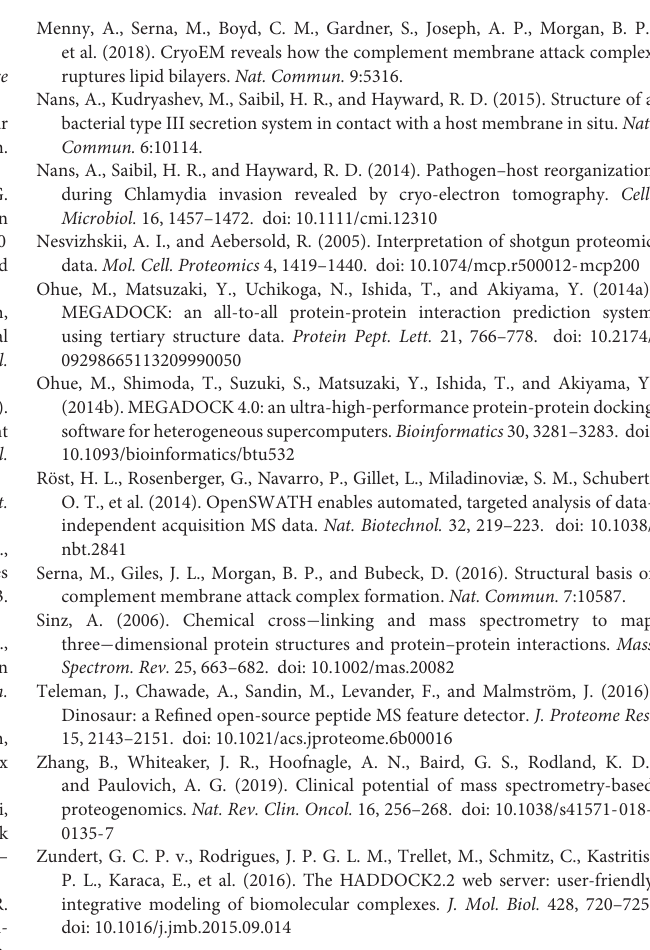
Supplementary Figure 2 | RMSD calculation between pairwise docking models and the native structures derived from protein data bank. The average RMSD for each pairwise interaction is calculated between all backbone atoms (CA, C, N, O) and is an average of five PyMOL alignment cycles. The average RMSD for